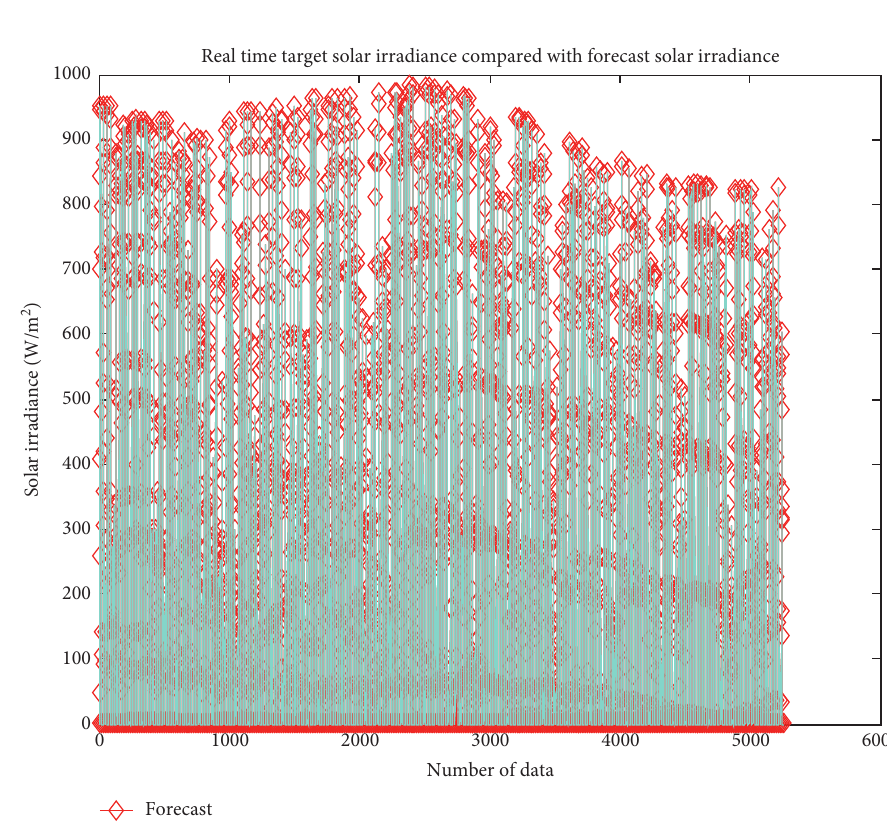
Figure 7: Real-time target solar irradiance compared with forecasted solar